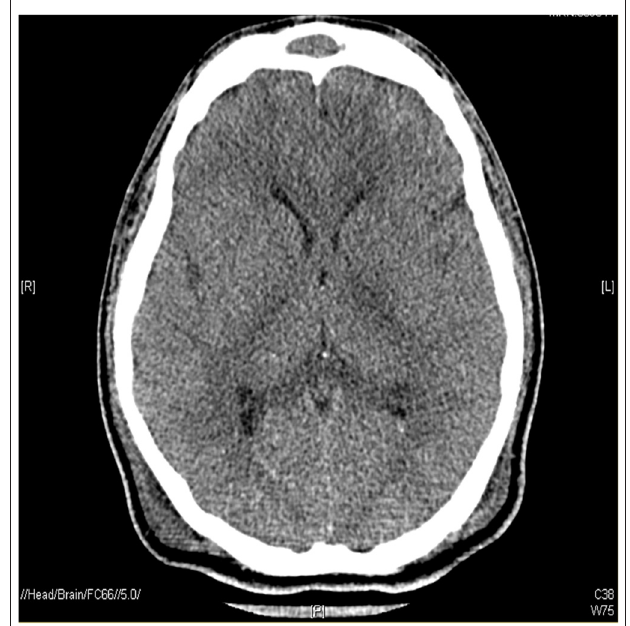
FIGURE 1 | Patient computed tomography scan recorded 43 days